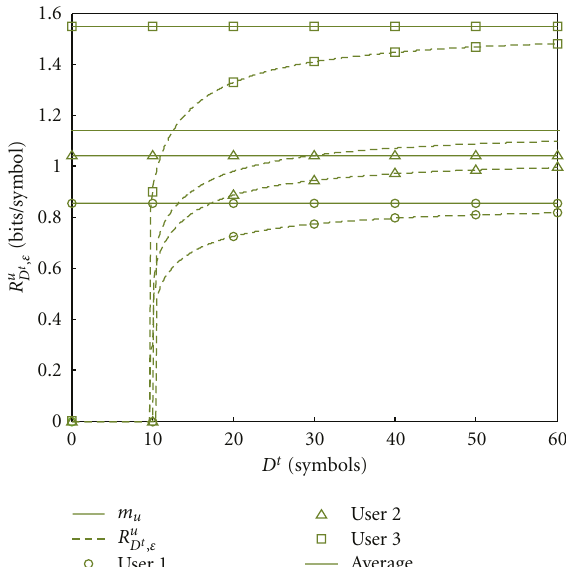
Figure 5: Achievable users’ rates with Proportional Fair scheduling in an uncorrelated channel. Three users with γ respectively. ε = 0 . 1. β u =